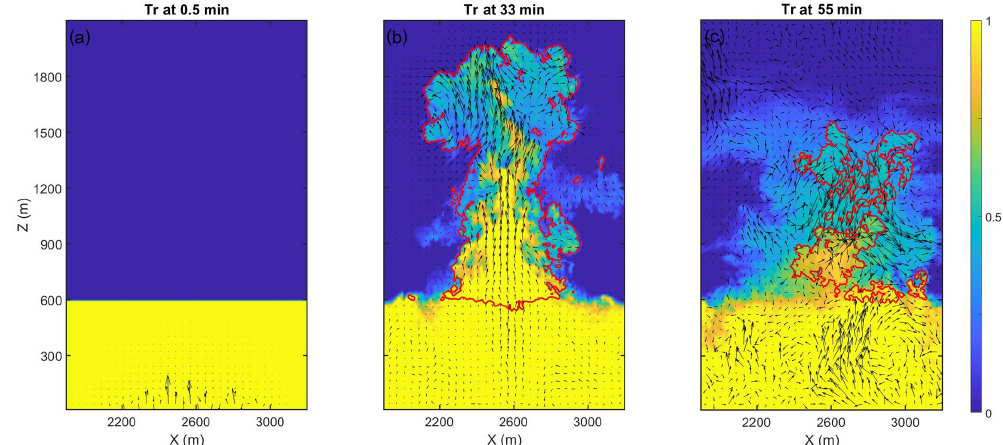
Figure A1. The sub-cloud layer’s passive tracer. Vertical cross sections of the tracer along the x axis in the middle of the domain. Tr is the tracer’s mixing ratio normalized by its initial mixing ratio in the sub-cloud layer. (a) The initial distribution at the beginning of the simulation. (b) Distribution at the time of the cloud’s maximal development (33min). Red contours mark the cloud boundaries where the liquid mixing ratio is smaller than 0.01gkg − 1 . (c) Same as (b) for the end of the simulation when the cloud is nearly completely dissipated.